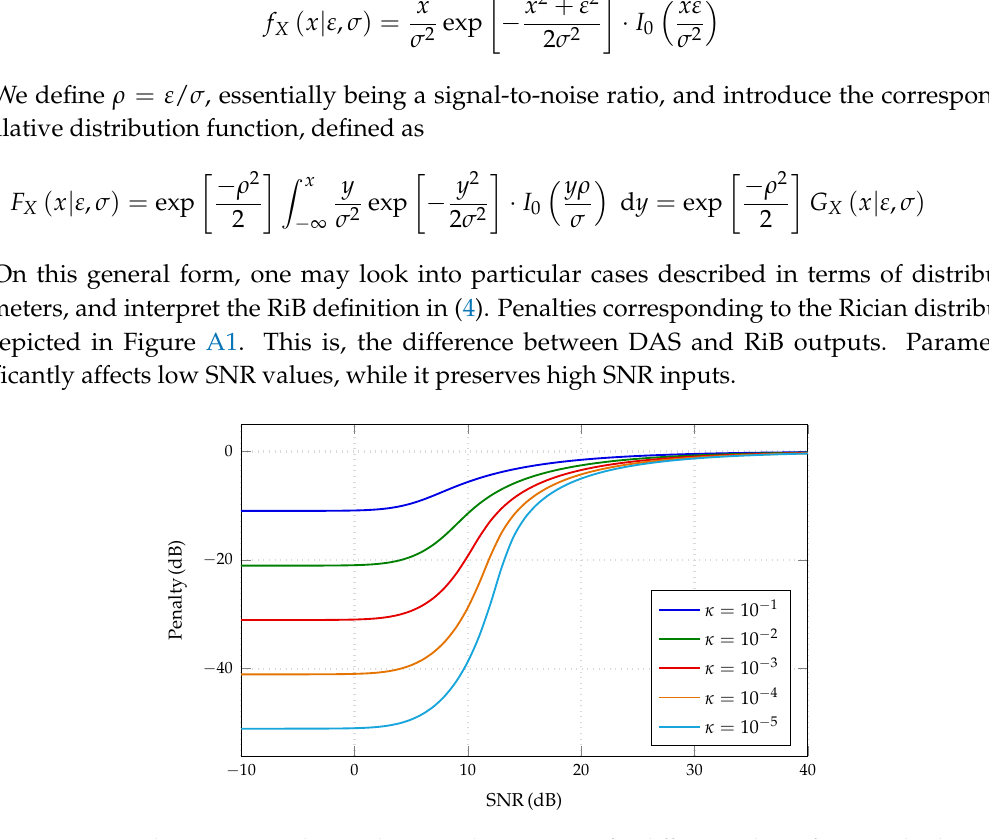
Figure A1. Penalties corresponding to the general, Rician case, for different values of SNR and κ , being ν , σ ) x = argmax f X ( x | x